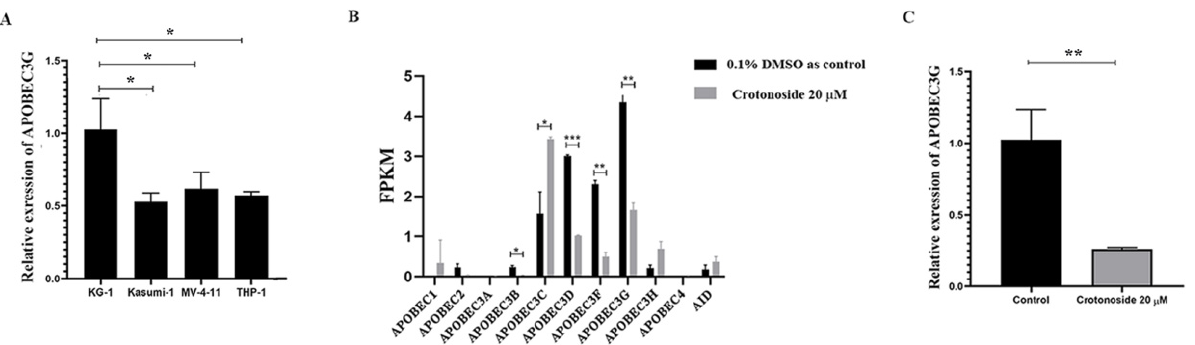
Figure 8. The mRNA expressions of the APOBEC3 family were evaluated in tested cells: ( A ) The relative endogenous mRNA expressions of APOBEC3G in AML cell lines were detected by qPCR. * p < 0.05 vs. KG-1. ( B ) The expression and changes in all the members of APOBEC family were detected by mRNA sequencing in KG-1 cell treated with 20 µ M crotonoside or with 0.1% DMSO as control for 48 h.* p < 0.05, ** p < 0.01, *** p < 0.001 vs. control group. ( C ) KG-1 cells were treated with 20 µ M crotonoside or 0.1% DMSO as control for 48 h, qPCR detected the efficiency of crotonoside on inhibiting the high expression of APOBEC3G compared with control, ** p < 0.01 vs. control group. All the data are presented as means ± SD from three independent experiments. FPKM: fragments per kilo base per